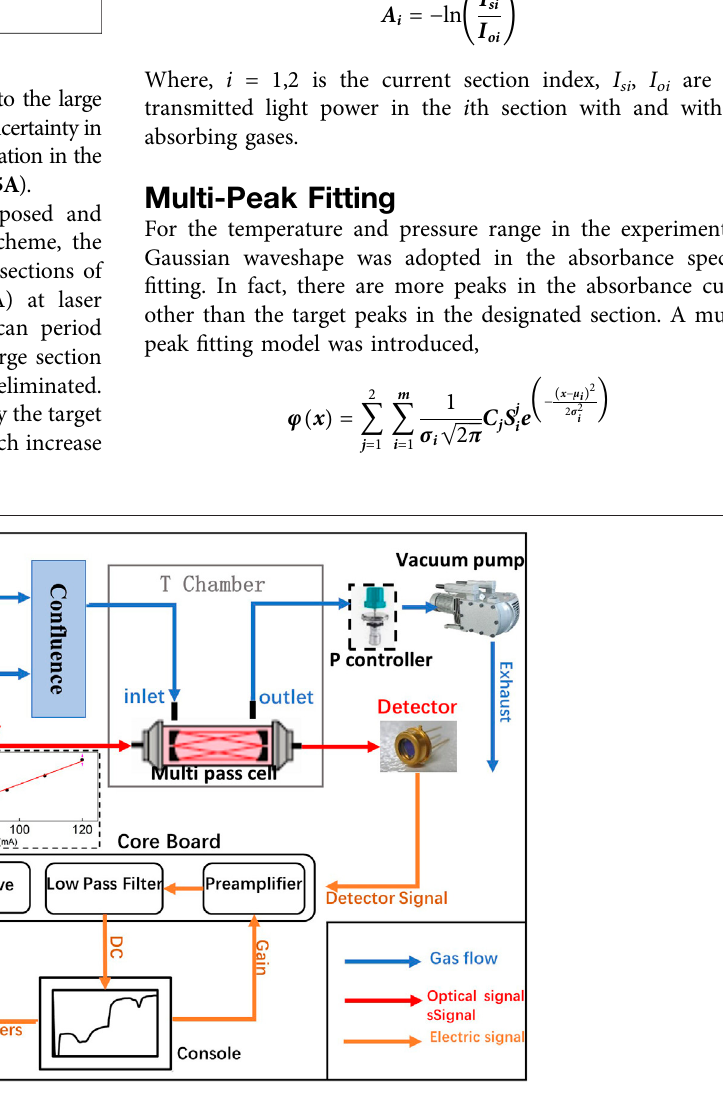
FIGURE 4 | (A) Laser current tuning curve (B) Laser temperature tuning curve.